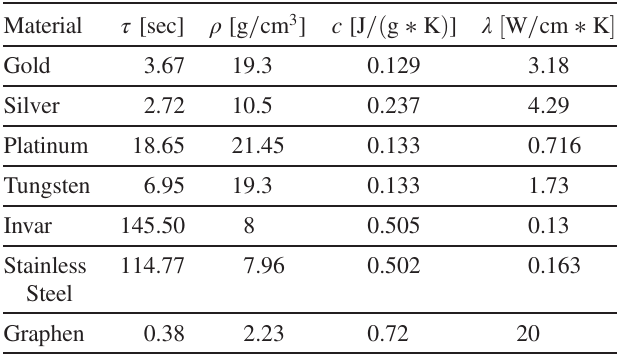
TABLE I. Response time for different target wire